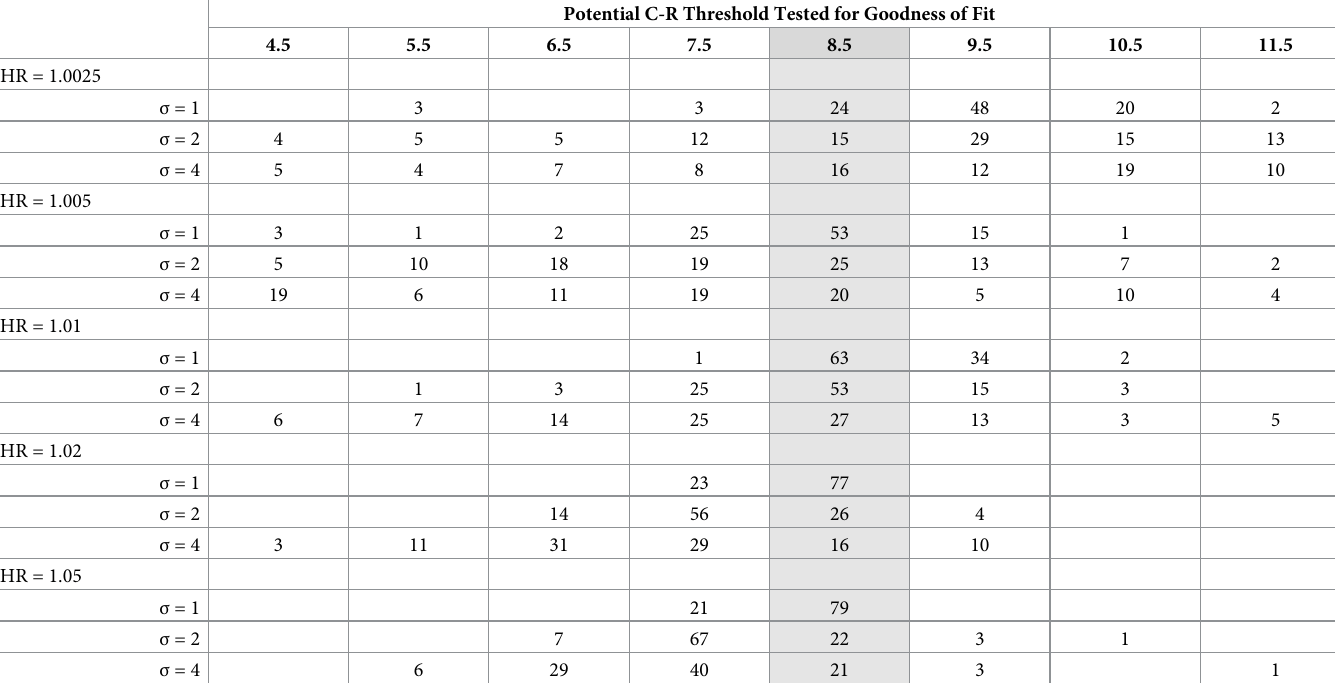
Table 3. Best-fitting C-R threshold level under varying amounts of measurement error, true threshold = 8.5.